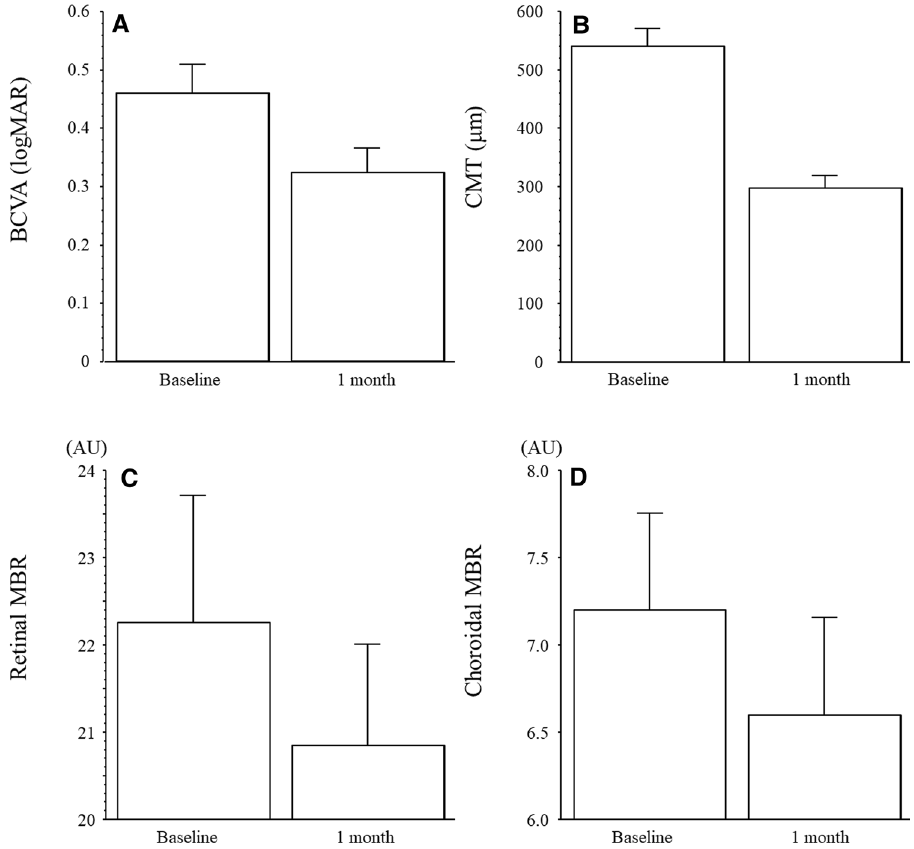
Figure 1. BCVA, CMT, Retinal and choroidal MBR at baseline and 1 month after IRI . ( A ) Significant changes were observed in mean BCVA between baseline (logMAR 0.46 ± 0.28) and 1 month (logMAR 0.32 ± 0.23; P < 0.001). ( B ) Significant changes were observed in mean CMT (from 539 ± 165 μm at baseline to 296 ± 117 μm at 1 month, P < 0.001). ( C ) Baseline retinal MBR was 22.2 ± 8.4 AU and decreased significantly 1 month (20.8 ± 6.7 AU) after IRI therapy ( P = 0.037). ( D ) Baseline choroidal MBR was 7.20 ± 3.17 AU and decreased significantly 1 month (6.59 ± 3.19 AU) after IRI therapy ( P = 0.003). BCVA, best corrected visual acuity; CMT,